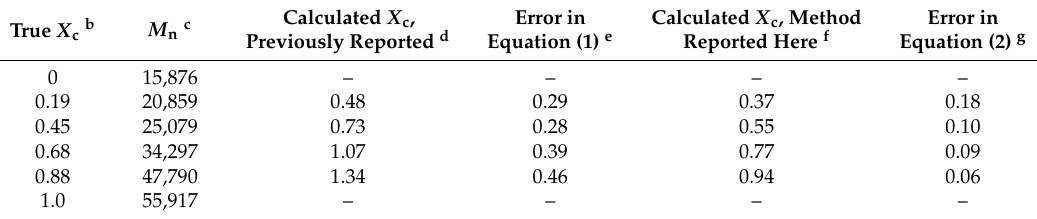
Table 2. Percent “Coupling” Calculations of Mixed PS Standards 17,500:50,000 a .